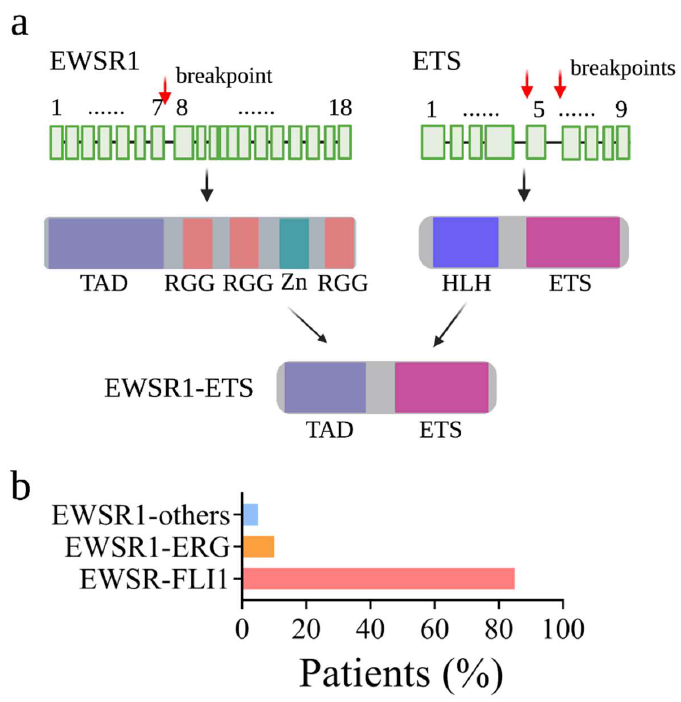
Figure 1. Schematic depiction of fusion protein EWSR1-ETS expressed from fusion genes generated by chromosomal translocation t(11;22)(q24;q12). ( a ) EWSR1 is composed of a transcription activation domain (TAD), three RGG domains, and a Zinc finger domain (Zn). ETS family members have a highly conserved ETS domain and a helix-turn-helix (HLH) structure. The fusion protein is induced by the fusion of the N-terminal TAD of EWSR1 and the C-terminal ETS domain of FLI1. Red arrows indicate the chromatin breakpoints frequently observed in the EwS patients; ( b ) Frequency of EWSR1-ETS fusions identified in EwS patients. Over 85% of EWSR1-ETS fusions involve the FLI1 gene. Around 10% of the EWSR1-ETS fusions are generated by ERG gene.